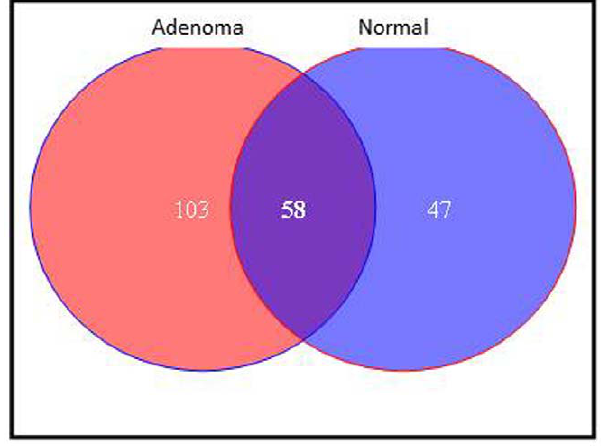
Figure 3. Adenoma and normal areas were extracted from microdissected of FFPE samples. Extracted peptides from adenoma and normal regions were separately subjected to LC-MS-MS/MS. Data were searched against human database and analyzed by Visualize software. After stringent filtration, 161 proteins were found to be expressed by the adenoma and 105 by the normal region . Of these, 103 proteins were found to be exclusively expressed in the adenoma.